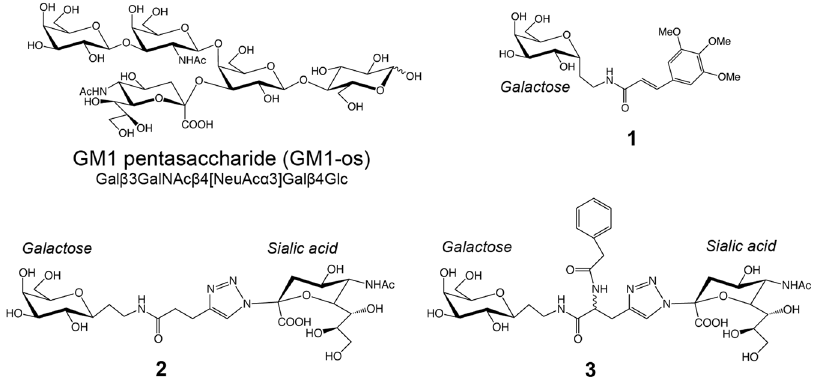
Figure 1. Schematic representation of GM1 pentasaccharide and inhibitors 1–3 . Carbohydrate residues are labelled, and the reducing end of GM1-os is indicated by a waved line. Compound 3 was used as a mixture of two stereoisomers ( R and S ), indicated by a waved line at the centre of the molecule. The figure was prepared with ChemBioDraw Ultra (PerkinElmer Informatics, Inc (www.cambridgesoft.com); version